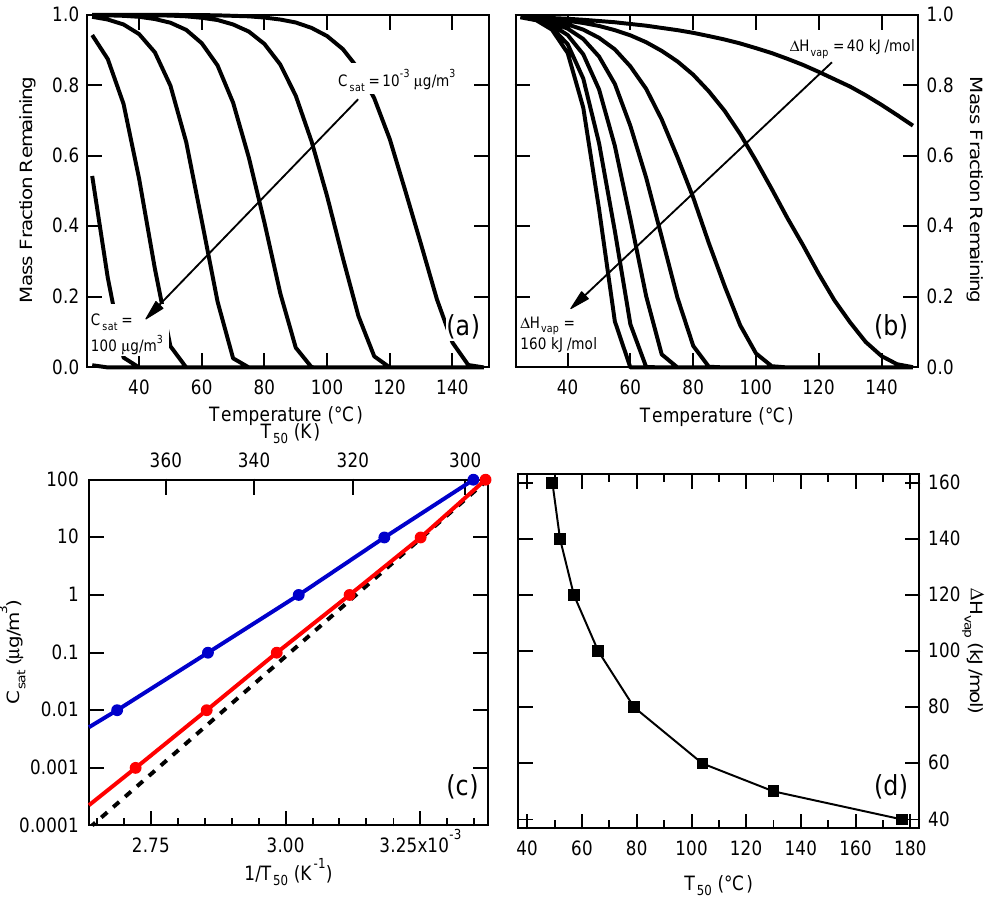
Fig. 8. (a) The calculated mass fraction remaining (MFR bp ) for particles passed through a thermal denuder is shown for different values of C sat , ranging from C sat =0.01 to 100µg/m 3 . The adsorbent denuder boundary condition (Case 1) was used. Here, it was assumed that d p =300nm, t res =15s, 1H vap =120kJ/mol, C OA =50µg/m 3 and γ e =1. (b) Same as (a), but where the 1H vap values were varied from 40 to 160kJ/mol (in 20kJ/mol steps) for C sat =1µg/m 3 . (c) The calculated T 50 is shown as a function of C sat and (d) as a function of 1H vap ( C sat =1µg/m 3 , d p =300nm). For (c), the calculations used 1H vap =120kJ/mol and d p =300nm (blue line) or 1H vap =150kJ/mol and d p =200nm (red line). Note that T 50 values in (c) are in K. The experimental C sat vs. 1/ T 50 relationship determined by Faulhaber et al. (2009) is shown for reference (dashed line). A MW of 150g/mol was assumed to convert vapor pressure to C sat